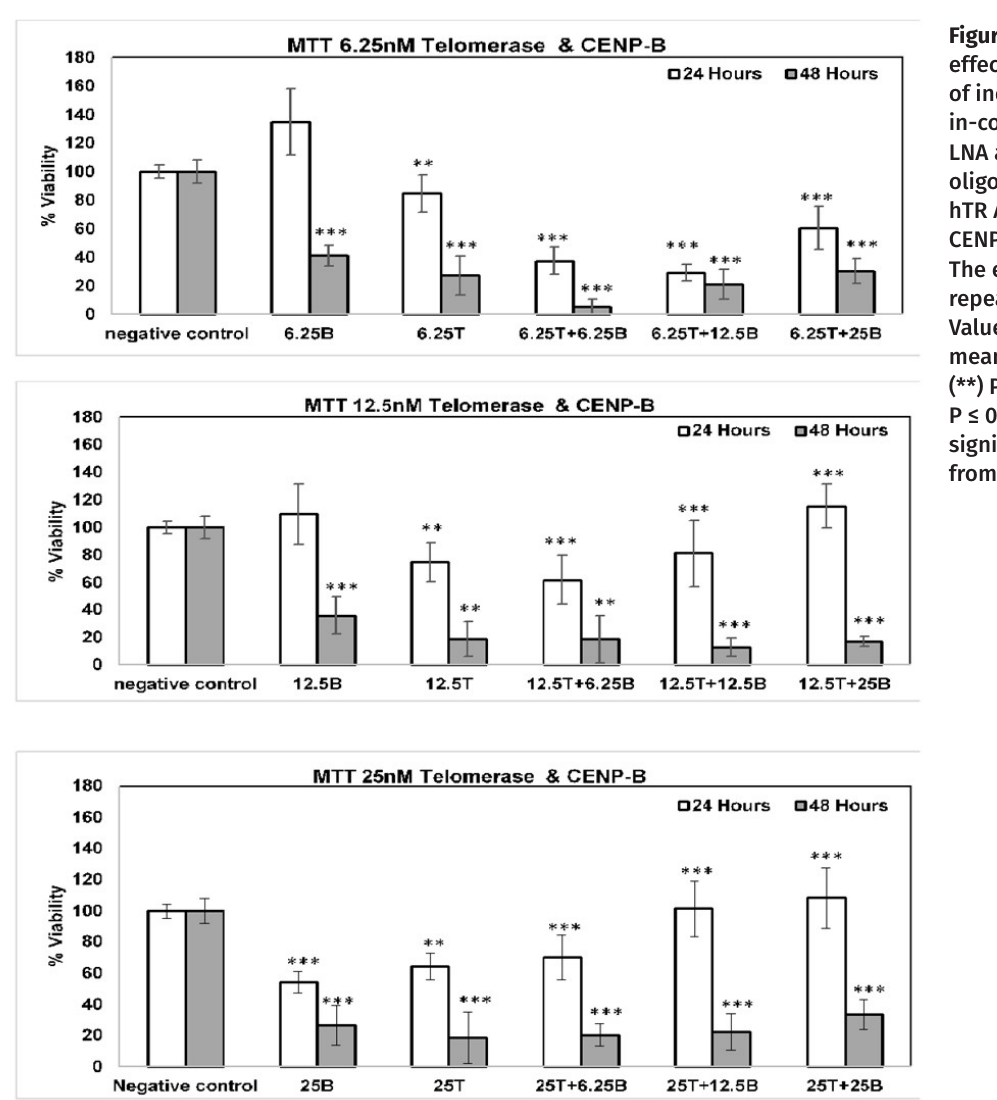
Figure 2. Cytotoxic effects comparison of individual and in-combination LNA antisense oligonucleotides hTR ASO (T) and CENP-B ASO (B). The experiment was repeated three times. Values are given as mean ± RSD. P ≤ 0.05, (**) P ≤ 0.01, and (***) P ≤ 0.001 represent significant changes from negative